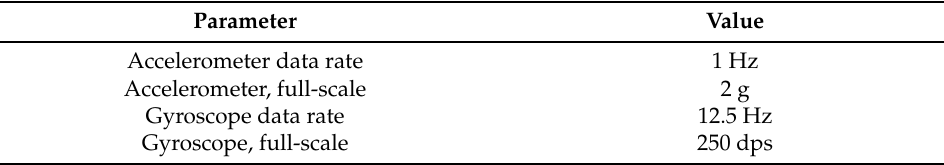
Table 1. IMU sensor configuration.